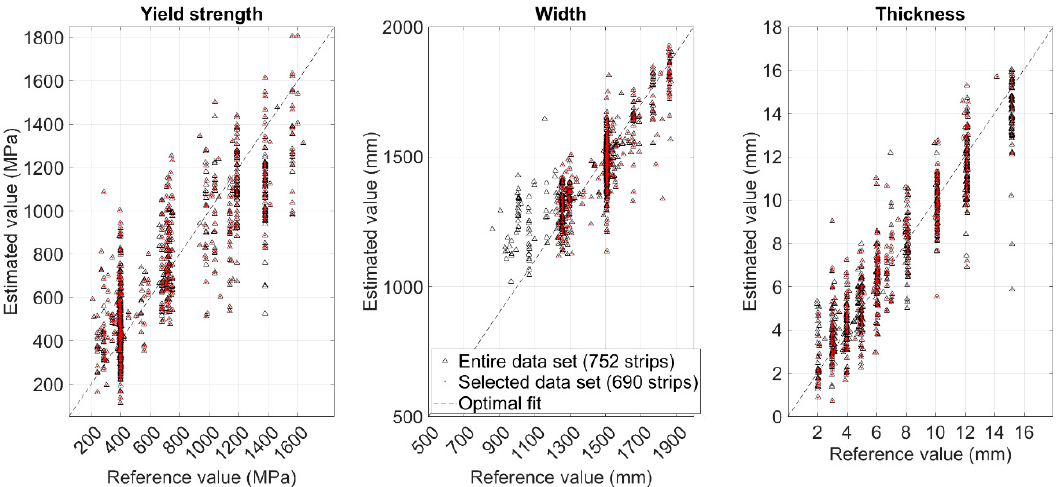
Figure 12. Scatter plots between the reference values and estimated values using the full set of 752 strips and the strips remaining after the removal of narrow ( ≤ 1200 mm) and thin ( ≤ 2 mm) strips.